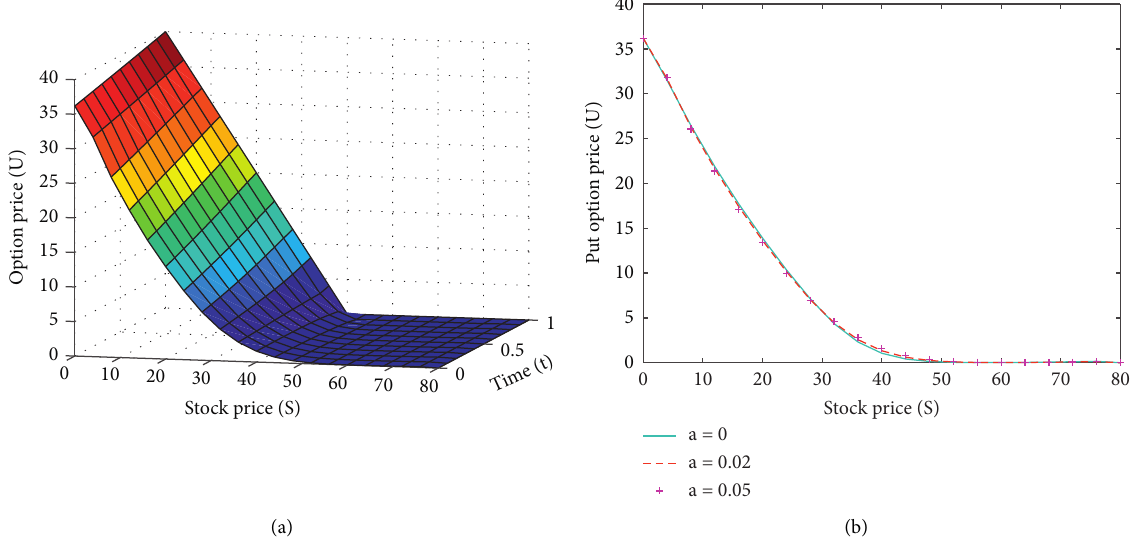
Figure 2: (a) European put option price charts of the explicit nonstandard method for a � 0 . 05 and (b) European option price charts of the explicit nonstandard method for different transaction costs in t �